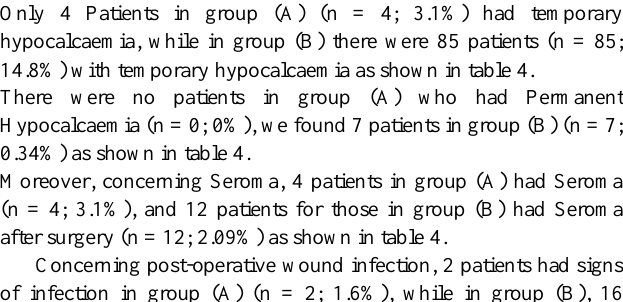
Table 5 : Distribution of post-operative complications (wound infection) of the study sample